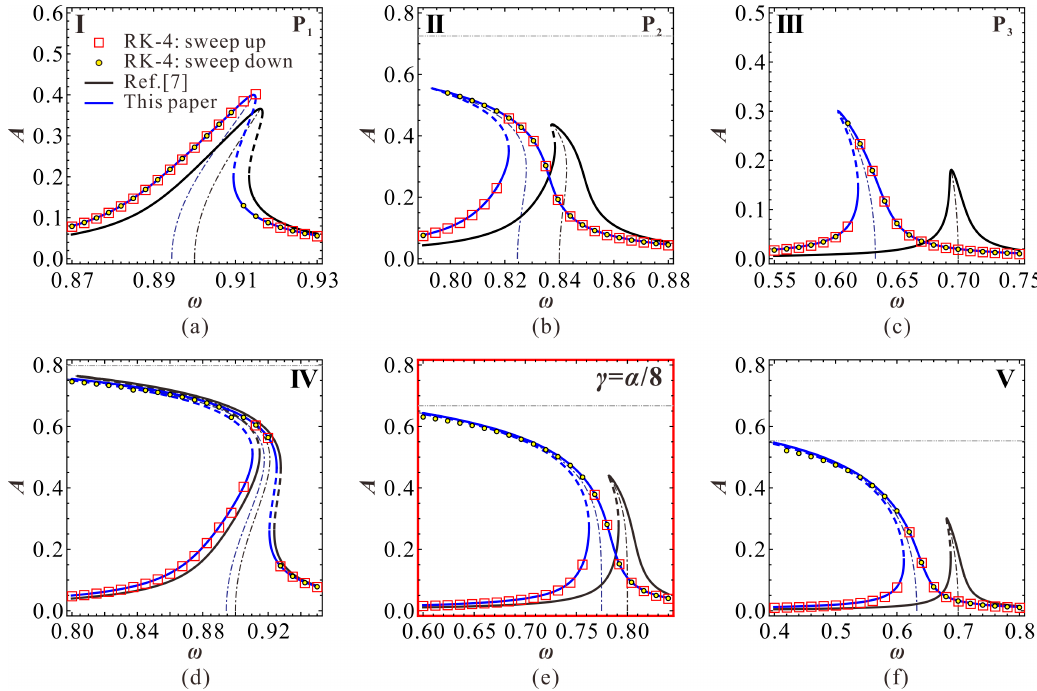
Figure 7. Frequency response curve with low energy corresponding to Figure 5 ( a ) γ = 0.05, ρ = 1.83 × 10 − 4 ; ( b ) γ = 0.08, ρ = 1.37 × 10 − 4 ; ( c ) γ = 0.15, ρ = 3.01 × 10 − 5 ; ( d ) γ = 0.05, ρ = 4 × 10 − 4 ; ( e ) γ = 0.1, ρ = 1.1 × 10 − 4 ; ( f ) γ = 0.15, ρ = 5 × 10 − 5 (solid line: stable solutions; dashed line: unstable